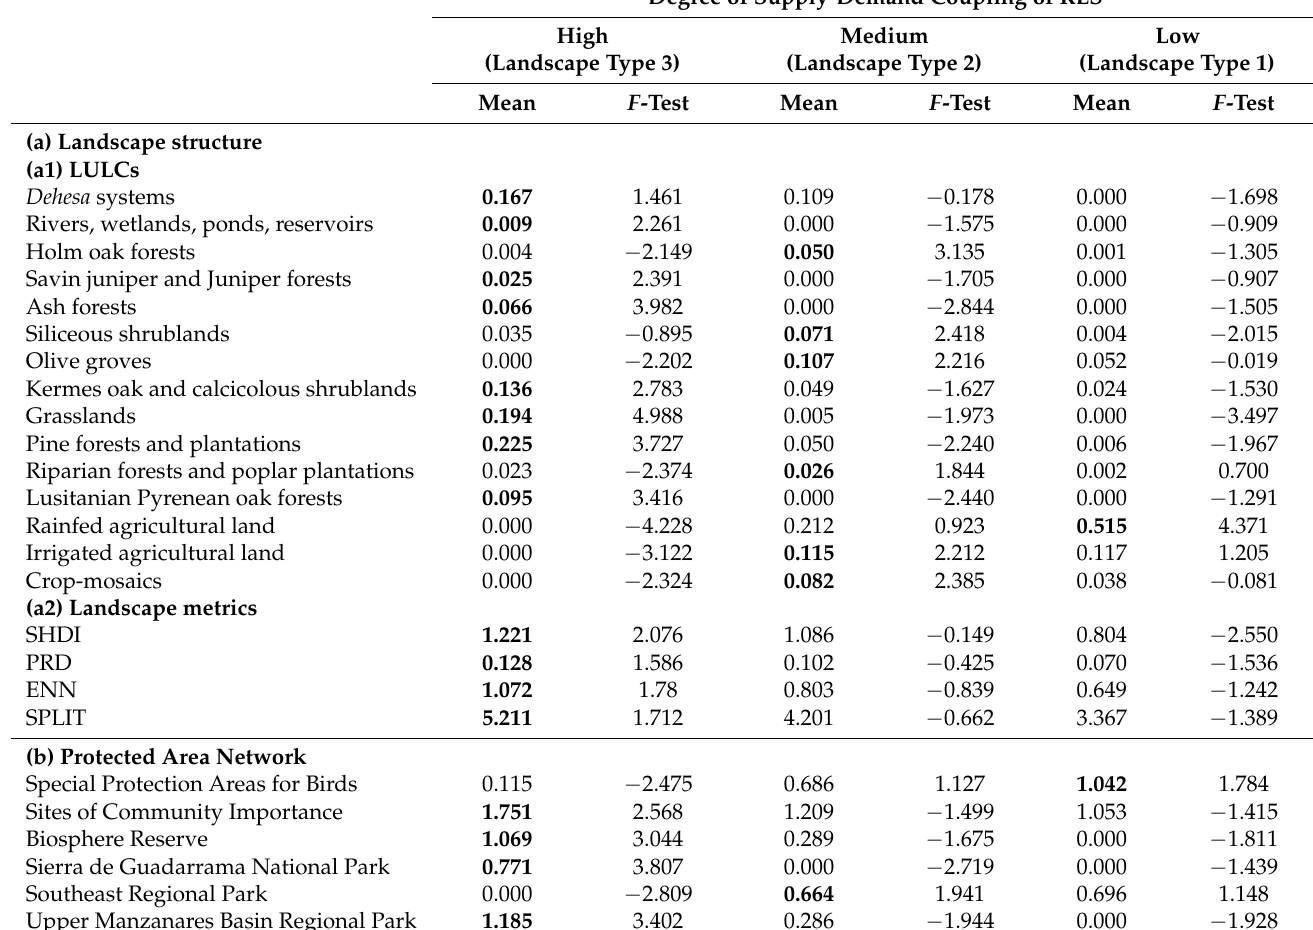
Table 4. Characterization of the types of municipalities with different degree of coupling between recreational supply and demand, identified along the rural-urban gradient studied. Relationship between the degree of RES coupling of the municipal types and: (a) Landscape structure: (a1) LULCs, considered as proxies of RES; (a2) landscape patterns, calculated from landscape metric indices; (b) Protected area network, with different management categories and protection degree. Data are expressed as mean values per municipality types. Statistically significant values (Fisher F -test; p -value ≤ 0.05) are indicated in